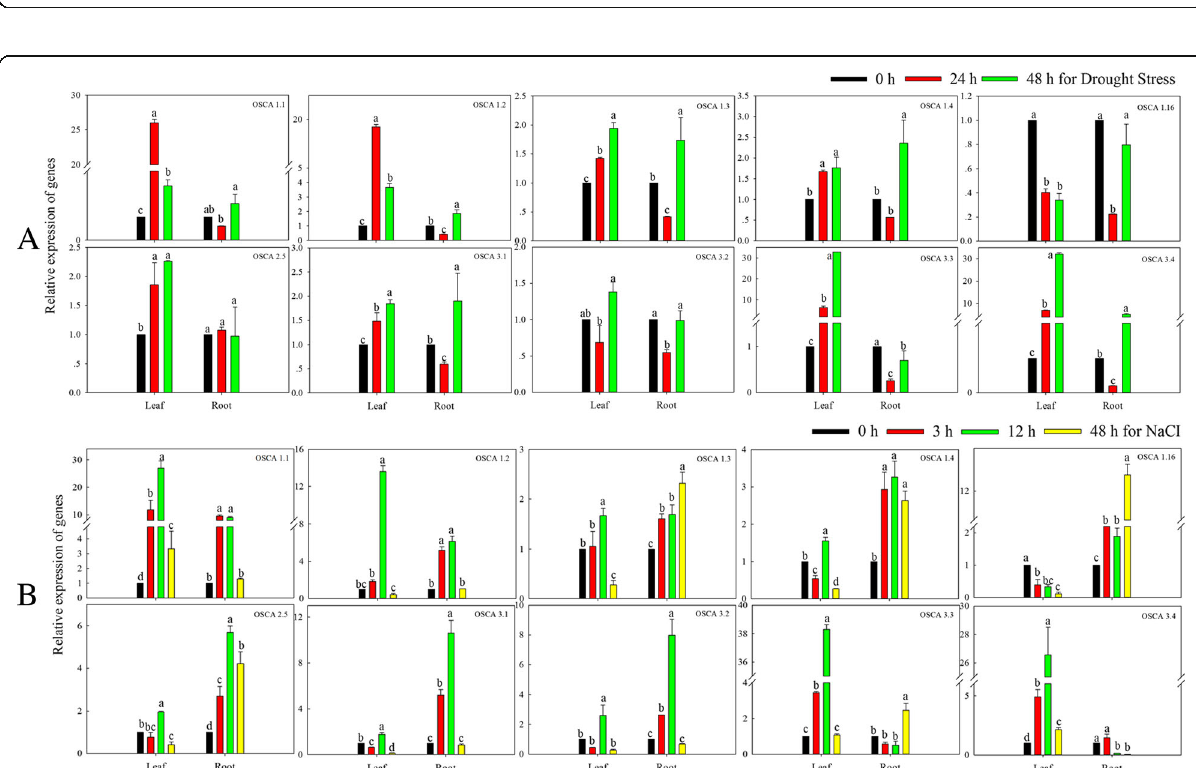
Fig. 7 Expression analysis of 10 selected GhOSCA genes using quantitative real-time RT-PCR (RT-qPCR). ( a ) RT-qPCR analysis of the selected GHOSCA genes under drought stress conditions, imposed by adding 17% of PEG-6000. ( b ) RT-qPCR analysis of the selected GHOSCA genes under salt stress conditions, imposed by adding 300 mM of NaCl solution. The relative expression level of 10 selected GhOSCA genes was normalized to the reference gene histone 2 in different tissues. The transcripts in non-stressed was set as 1 for each gene in different tissues. The bars show the standard deviation of three technical repeats. Different letters indicate significant differences in the expression levels of the genes in tissues at different time, 0 h, 24h and 48h of drought stress exposure, while for salt stress conditions, samples were taken at 0h, 3h, 12h and 48h of post salt stress exposure (ANOVA; P < 0.05). 0 h: normal